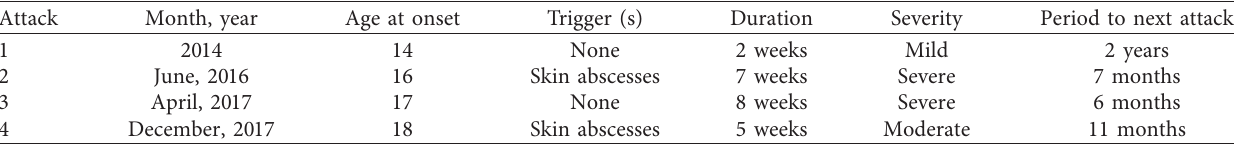
Table 1: Previous